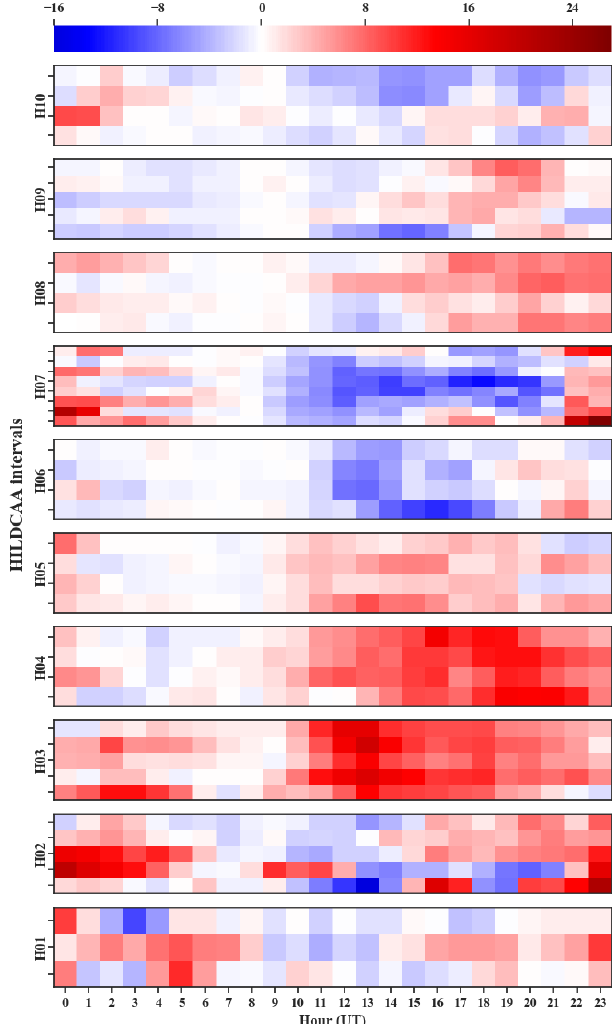
Figure 2. dTEC hourly values for all HILDCAA intervals at São Luís (equatorial